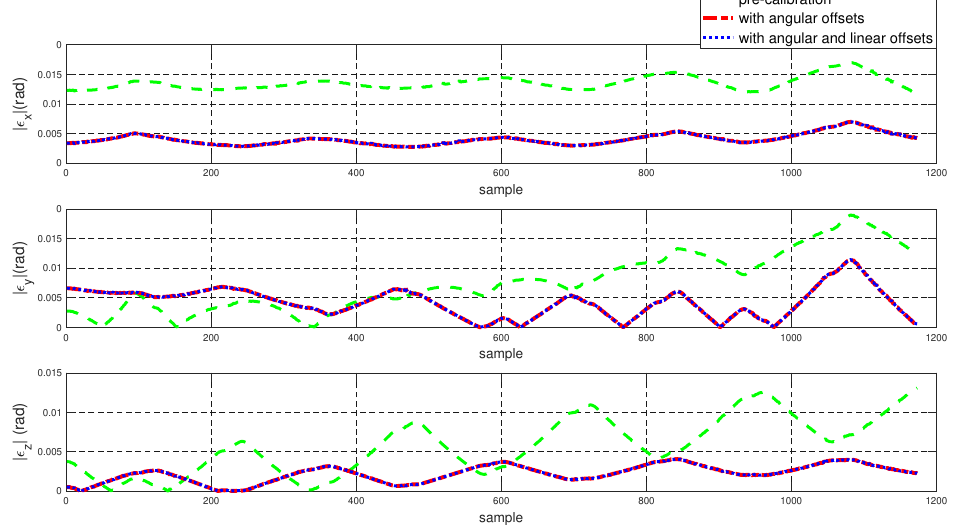
Figure 8. Error in end-effector orientation error ( R T (cid:101) R − I ) ∨ for the test dataset before and after